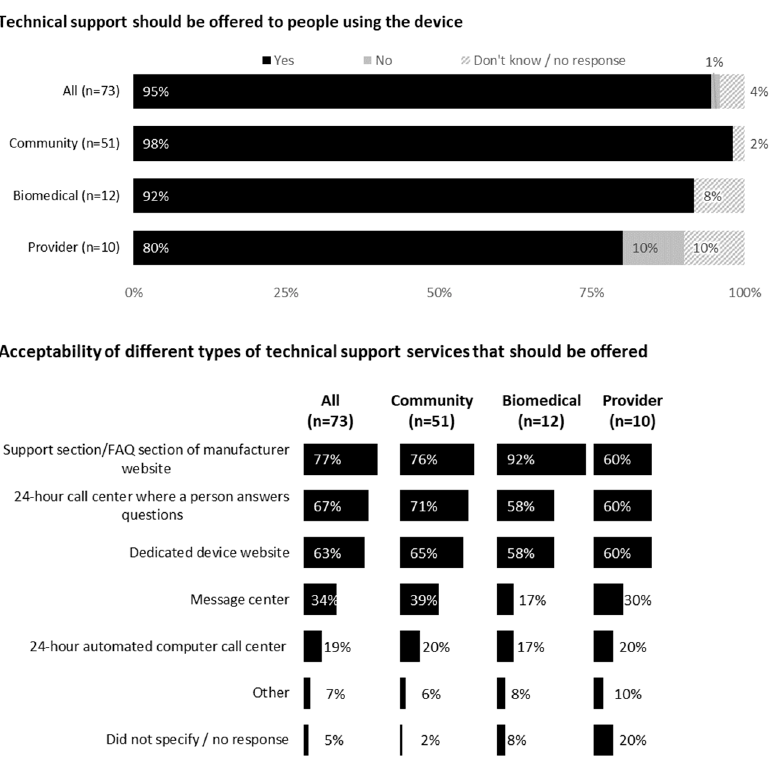
Figure 5. Feedback on technical support for using the device from all participants (United States, 2021).